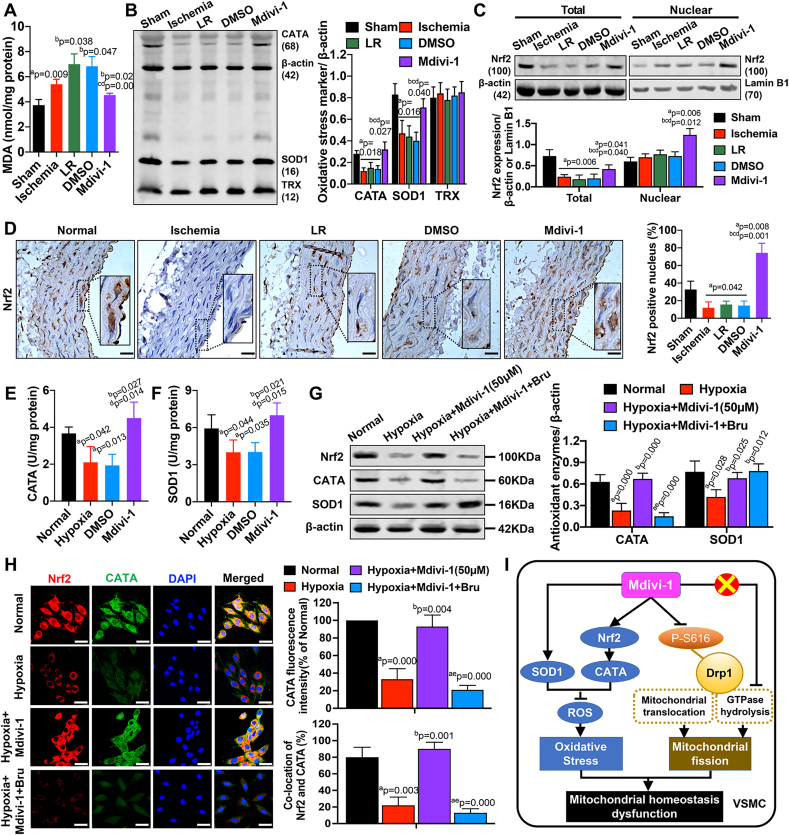
Effects of Mdivi-1 on oxidative stress markers in vivo and in vitro. (A)The level of malondialdehyde (MDA) in SMA tissues (n = 8 rats/group). (B) The protein expression of key antioxidant enzymes including catalase (CATA), superoxide dismutase 1(SOD1) and thioredoxin (TRX) in SMA tissues (n = 8 samples/group). (C) The total and nuclear expression of Nrf2 in SMA tissues (n = 8 samples/group). (D) The expression and distribution of Nrf2 in SMA tissues (n = 8 samples/group). (E) The level of catalase (CATA) in VSMCs (n = 8 samples/group). (F) The level of catalase (CATA) in VSMCs (n = 8 samples/group). (G) The protein expression of catalase (CATA) and superoxide dismutase 1(SOD1) in VSMCs (n = 8 samples/group). Bru = Brusatol, the Nrf2 inhibitor. (H) Confocal images showing the expression of Nrf2 and catalase (CATA) in VSMCs (n = 8 images/group). Bru = Brusatol. (I) Schematic diagram showing the possible signaling mechanisms of Mdivi-1 in hemorrhagic shock. a: P < 0.05 compared with Sham or Normal group, b: P < 0.05 compared with Shock or Hypoxia group, c: P < 0.05 compared with LR group, d: P < 0.05 compared with DMSO group, e: P < 0.05 compared with Hypoxia + Mdivi-1 group.